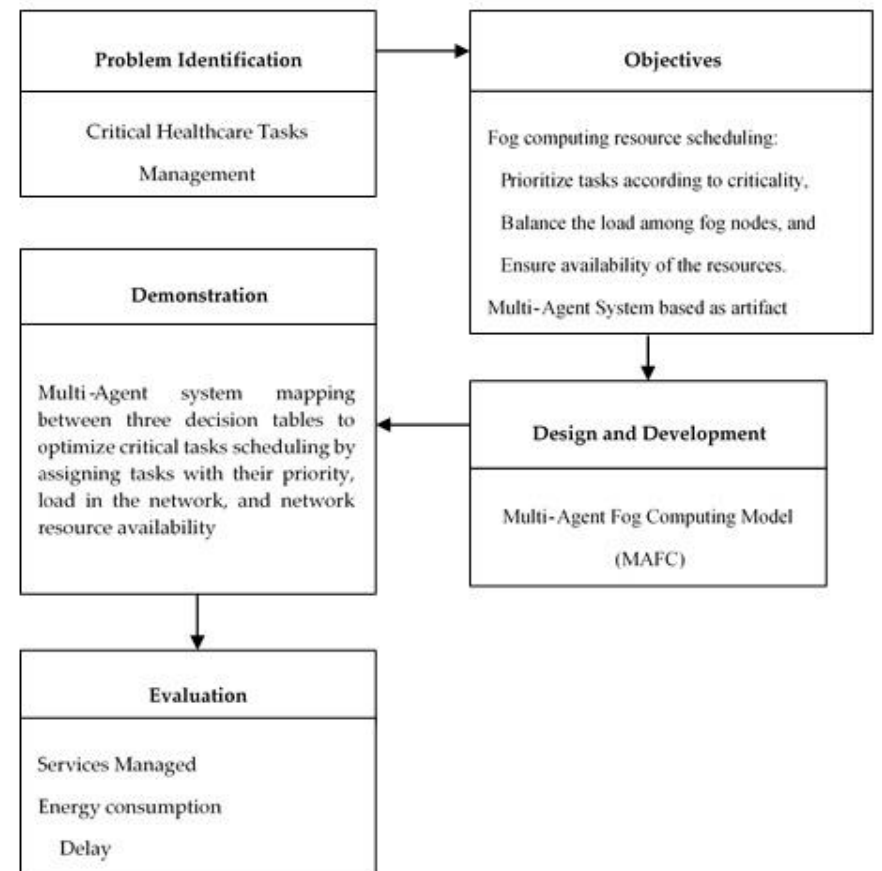
Figure 2. Research methodology overview.